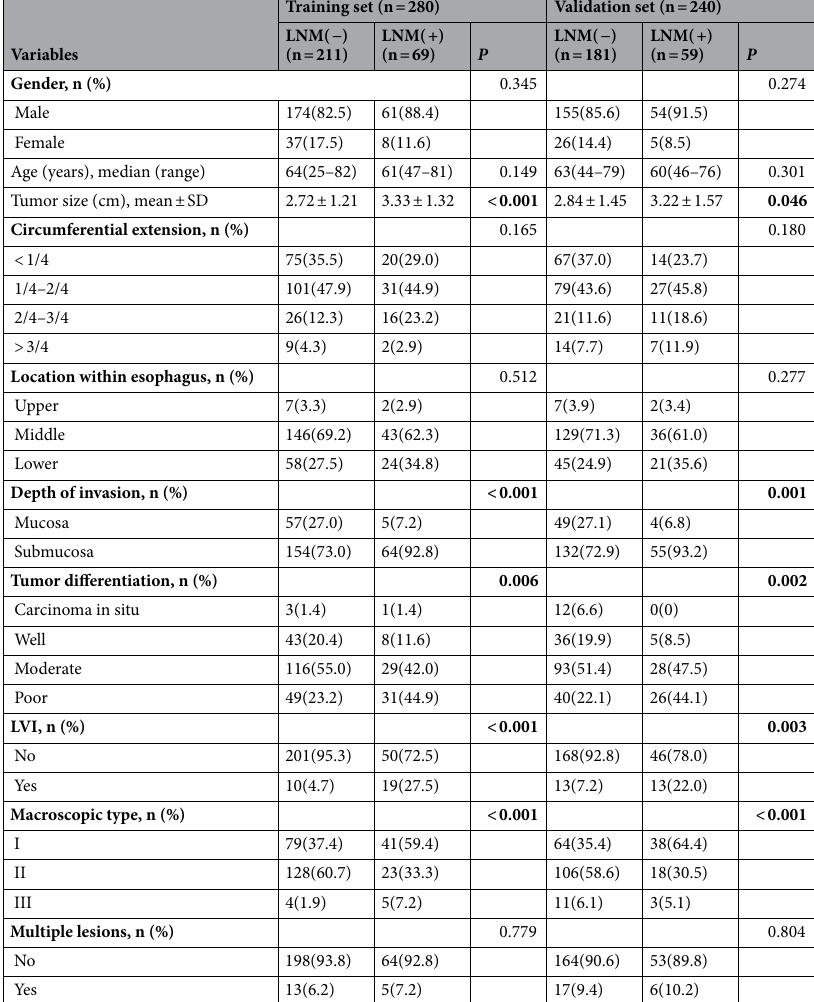
Table 2. Clinicopathologic findings according to lymph node metastasis in training and validation sets. The bold values mean statistical significance. LVI, lymphovascular invasion; LNM, Lymph node metastasis; I = superficial and protruding type; II = flat type; III = superficial and excavated type; P: Categorical variables— χ 2 test or Fisher’s exact test; Continuous variables—Mann–Whitney